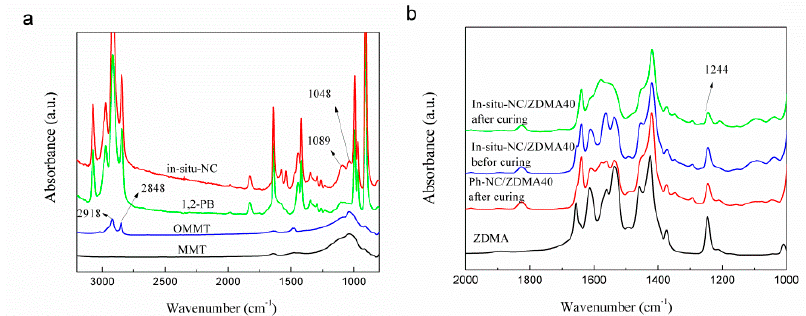
Figure 3. FTIR spectra of ( a ) MMT, OMMT, 1,2-PB, and in-situ-NC, ( b ) ZDMA, in-situ-NC/ZDMA40 before and after curing, and ph-NC/ZDMA40.